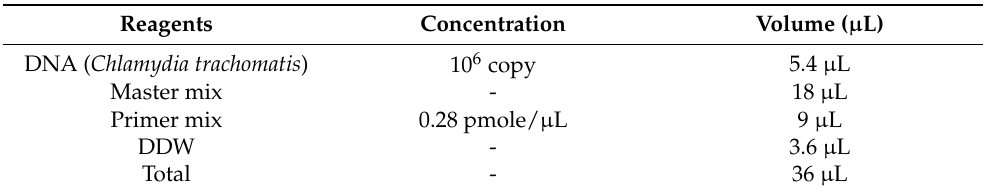
Table 3. PCR sample composition.